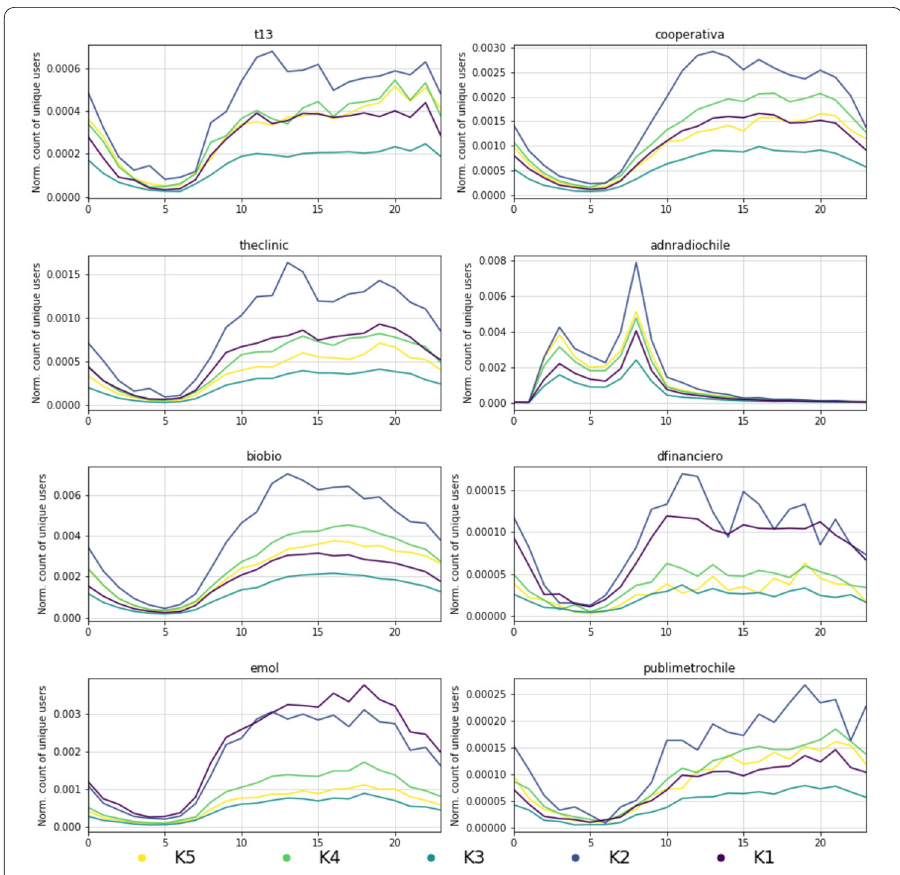
Figure 9 Unique users over the whole time window studied, detailed by hour, by news outlet and by cluster. On the horizontal axis we have the time of the day, and on the vertical axis the normalized number of users. These plots show us how the different clusters contribute to the web traffic of the individual news